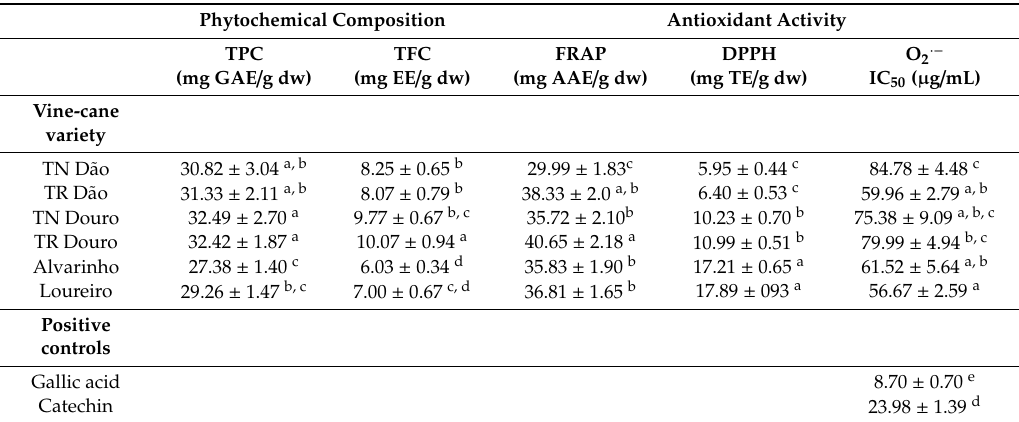
Table 1. Phytochemical composition and antioxidant activity of vine-cane subcritical water extracts from Touriga Nacional (TN) and Tinta Roriz (TR) varieties from D ã o and Douro regions, Alvarinho and Loureiro varieties; results are expressed as mean ± standard deviation ( n =